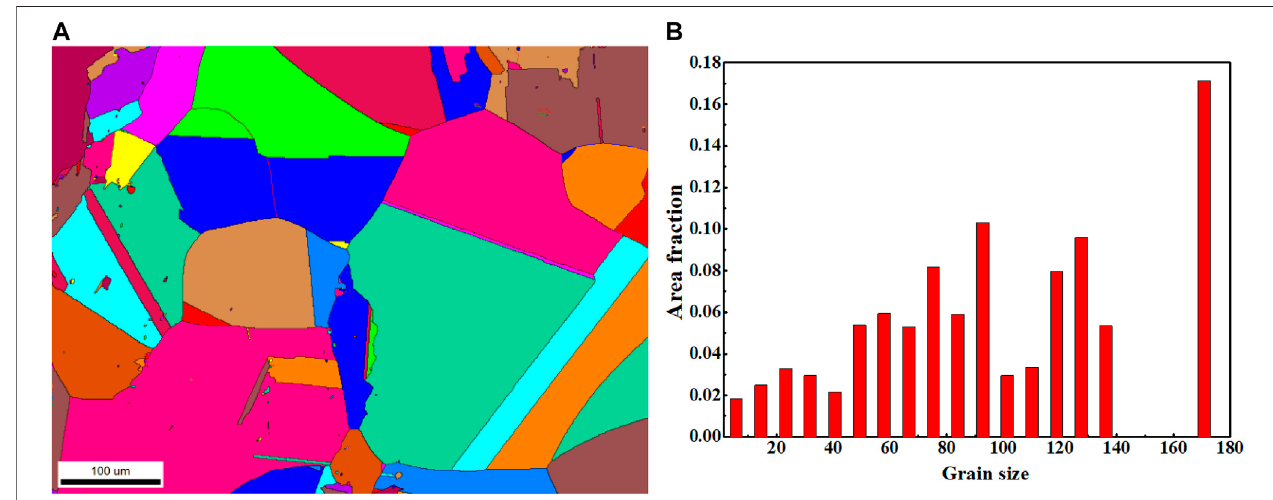
FIGURE 1 | Microstructure of the solution-treated superalloy: OIM map (A) and grain size distribution (B) .